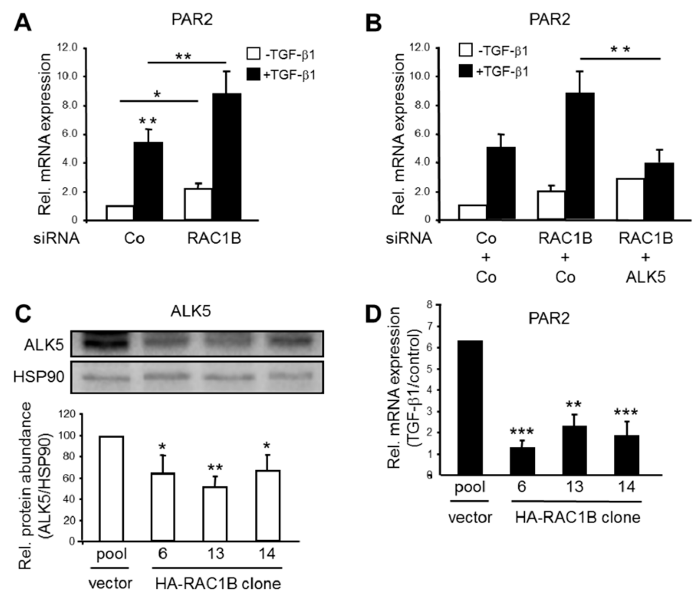
Figure 1. Effect of RAC1B knockdown or ectopic overexpression on TGF- β 1-induced gene expression of PAR2. ( A ) Panc1 cells were transfected twice with 50 nM each of either control (Co) siRNA or RAC1B siRNA. Forty-eight hours after the second round of transfection, cells were treated with TGF- β 1 for 24 h and subsequently subjected to qPCR analysis for PAR2. ( B ) As in ( A ), except that Panc1 cells were cotransfected with 25 nM each of Co siRNAs specific for RAC1B and ALK5, or 25 nM each of RAC1B siRNA + ALK5-specific Co siRNA, or 25 ng each of RAC1B siRNA + ALK5 siRNA prior to TGF- β 1 treatment and qPCR analysis of PAR2. Data in ( A ) and ( B ) represent the normalized mean ± SD from three independent experiments and are displayed relative to control siRNA set arbitrarily at 1. ( C ) Three individual clones of Panc1 cells with stable ectopic expression of HA-tagged RAC1B (HA- RAC1B) were subjected to immunoblot analysis of ALK5. The graph below the immunoblot shows results from densitometry-based quantitative analysis. ( D ) As in (C) except that cells were treated, or not, with TGF- β 1 for 48 h and subjected to qPCR analysis of PAR2. Data in (C) and (D) represent the normalized mean ± SD of three parallel wells from one representative experiment out of three experiments performed with very similar results. The asterisks indicate significance.